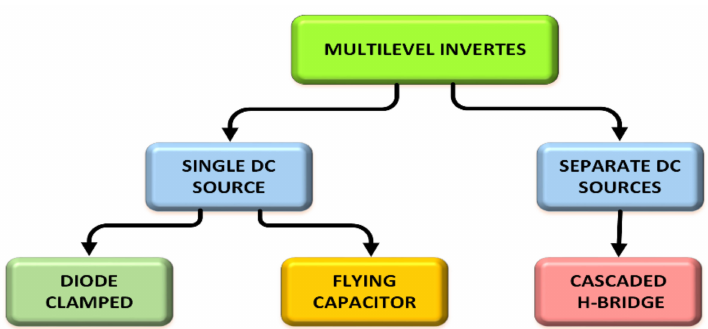
Figure 2. Multilevel inverters (MLIs) and their classification.